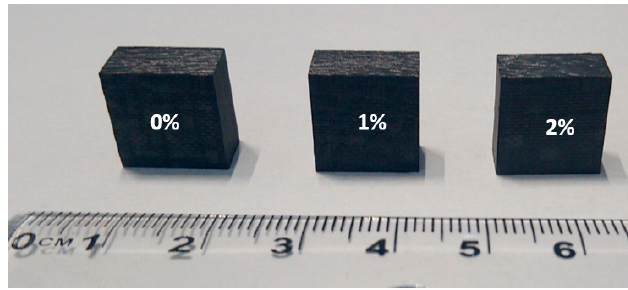
Figure 4. Specimens with different percentages dedicated to dynamic compression tests.